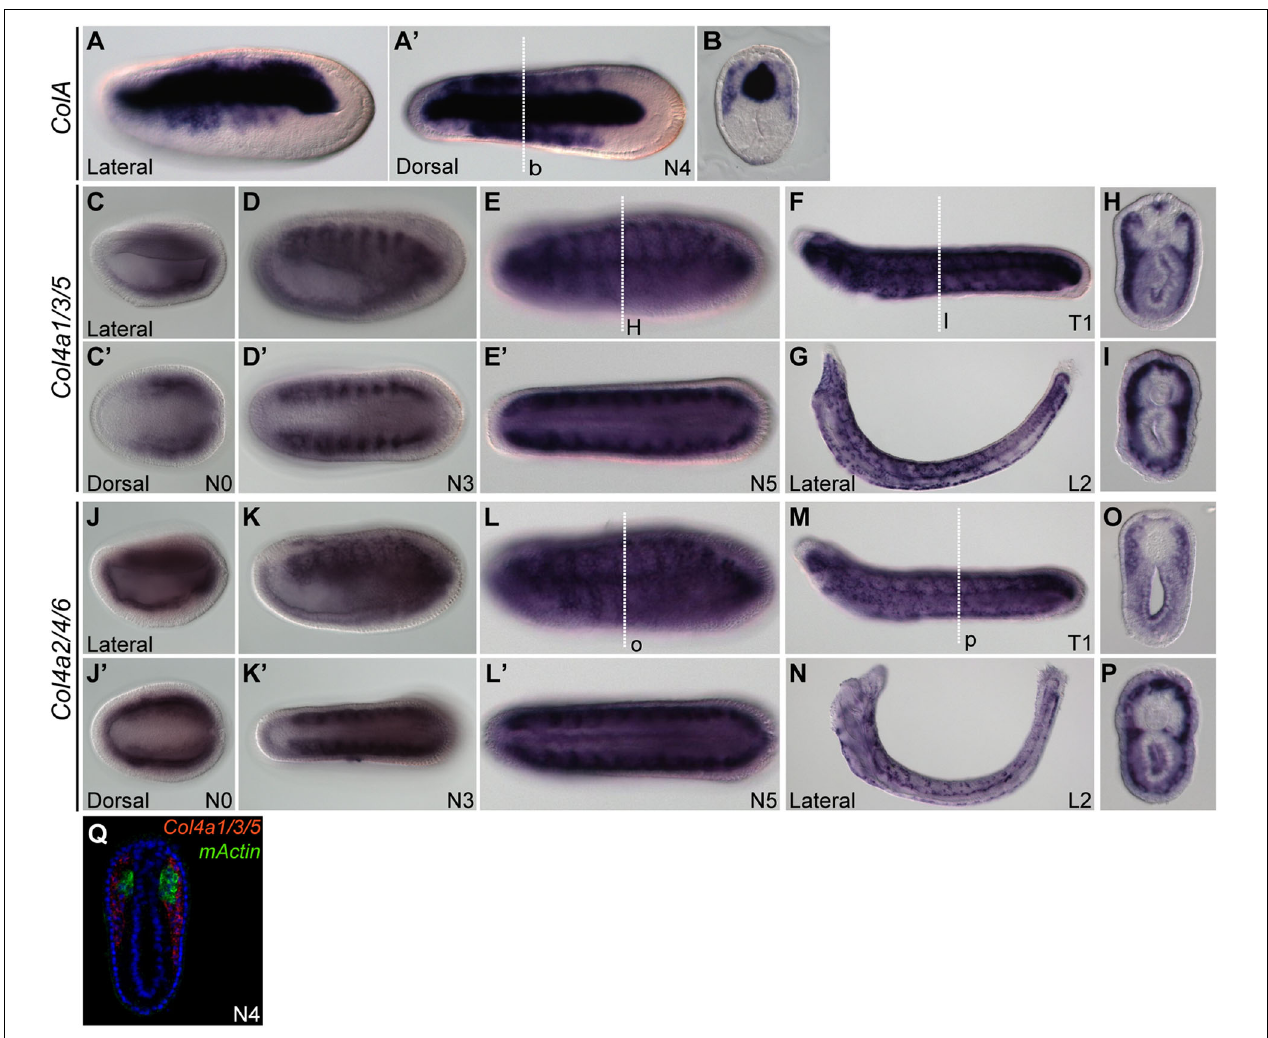
FIGURE 2 | Expression domains of amphioxus CollagenA ( ColA ) and CollagenIV ( Col4 ) genes. (A,B) Expression pattern of ColA (A,A (cid:48) ) N4 stage embryo, lateral and dorsal views. (B) Cross section of N4 embryo in panel (A (cid:48) ) at the level marked with a white dashed line. (C–I) Expression pattern of Col4a1/3/5 . (C,C (cid:48) ) N0 stage embryo, lateral and dorsal view. (D,D (cid:48) ) N3 stage embryo, lateral and dorsal view. (E,E (cid:48) ) N5 stage embryo, lateral and dorsal view. (F) T1 stage larva, lateral view. (G) L2 stage larva, lateral view. (H) Cross section of the N5 embryo in panel (E) at the level marked with a white dashed line. (I) Cross section of the T1 larva in panel (F) at the level marked with a white dashed line. (J–P) Expression pattern of Col4a2/4/6 . (J,J (cid:48) ) N0 stage embryo, lateral and dorsal view. (K,K (cid:48) ) N3 stage embryo, lateral and dorsal view; Col4a2/4/6 is expressed in the lateral part of the somite and minimally in the endoderm. (L,L (cid:48) ) N5 stage embryo, lateral and dorsal view. (M) T1 stage larva, lateral view. (N) L2 stage larva, lateral view. (O) Cross section of the N5 stage embryo in panel (L) at the level marked with a white dashed line. (P) Cross section of T1 stage larva in panel (M) at the level marked with a white dashed line. (Q) Cross section of N4 stage double FISH of Col4a1/3/5 with mActin